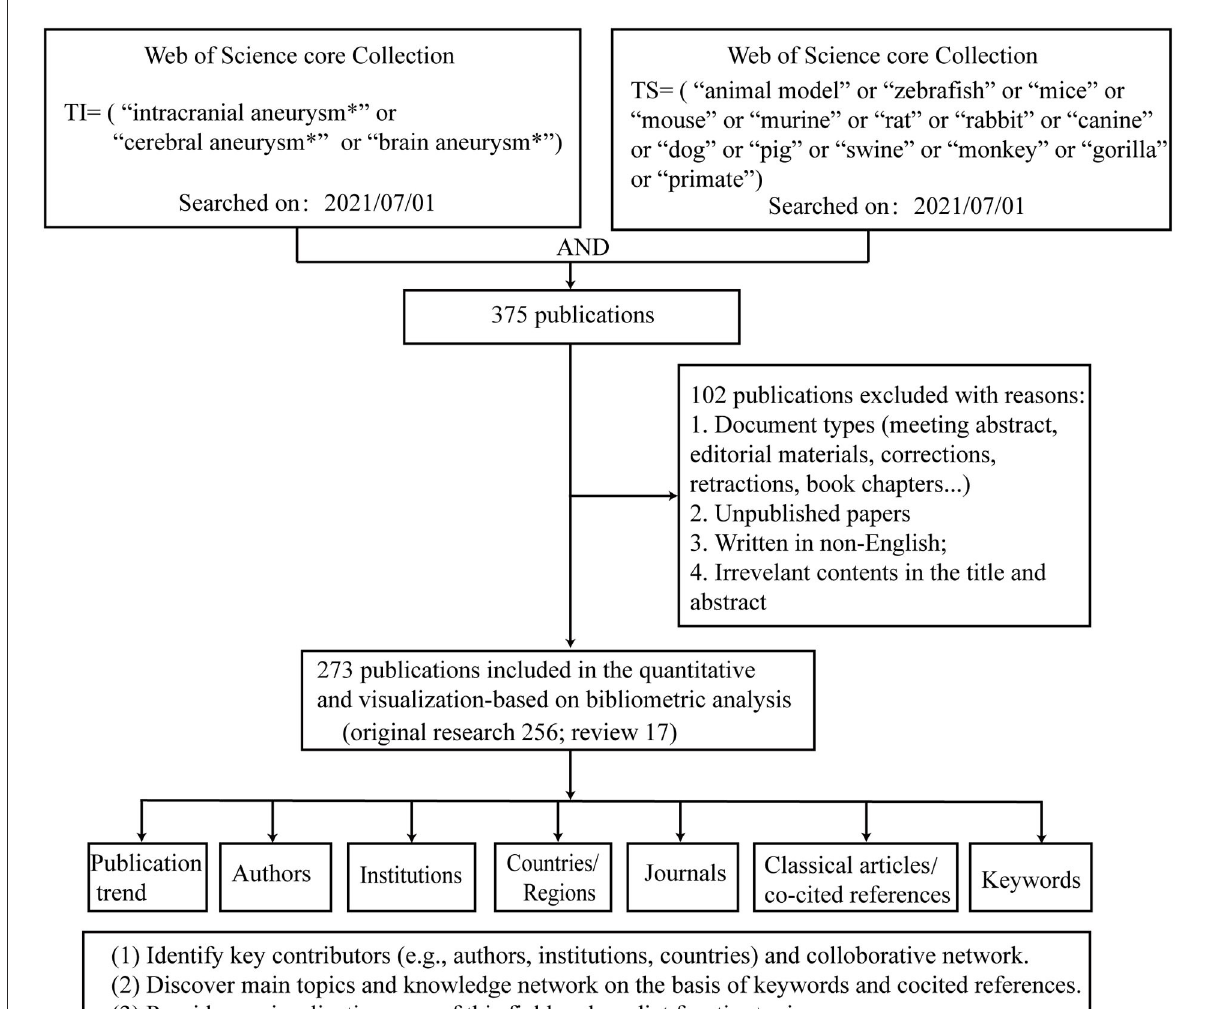
FIGURE1 Flowchart of data screening and